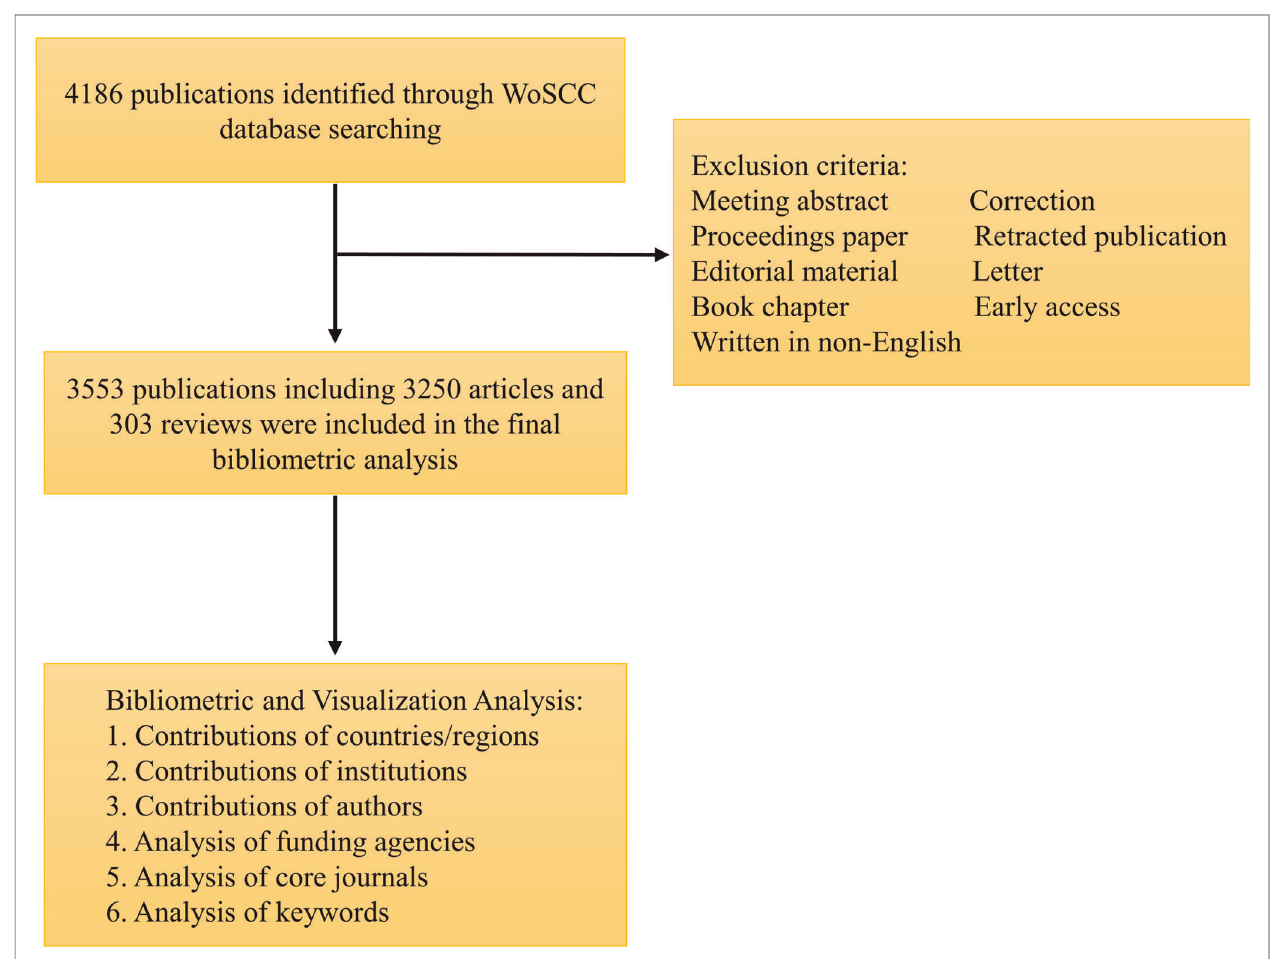
FIGURE 1 | Flowchart for the selection of literature included in this